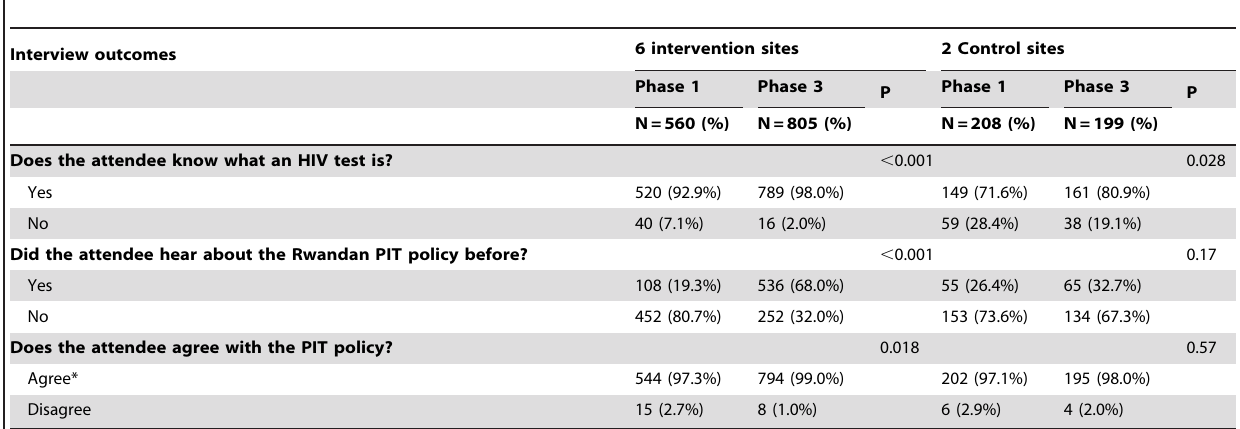
Table 3. Outcomes from interviews of clinic attendees at intervention and control sites, PITC study, Rwanda, 2009–10.